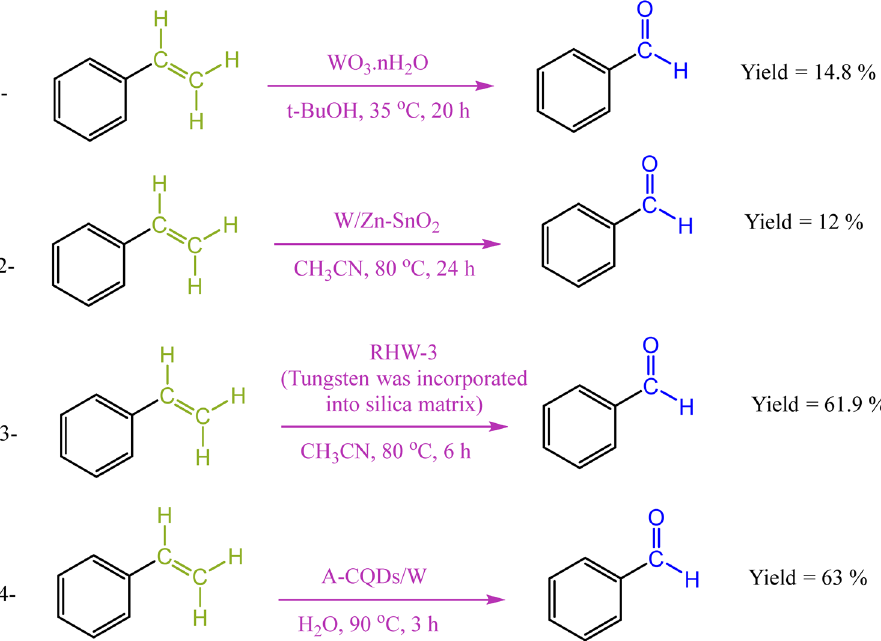
Scheme 1. Comparison of the activity of A-CQDs/W catalyst in oxidative cleavage of styrene to benzaldehyde with the reported tungsten-based